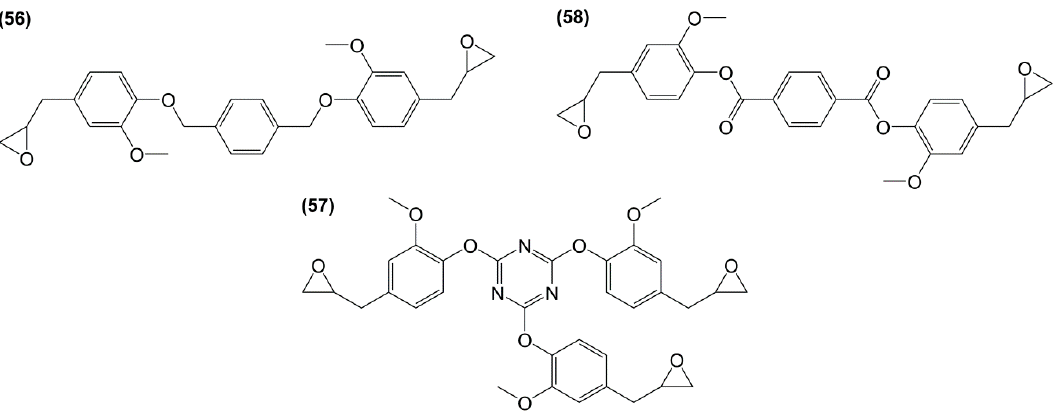
Figure 31. Eugenol-based poly-aromatic epoxy monomers.